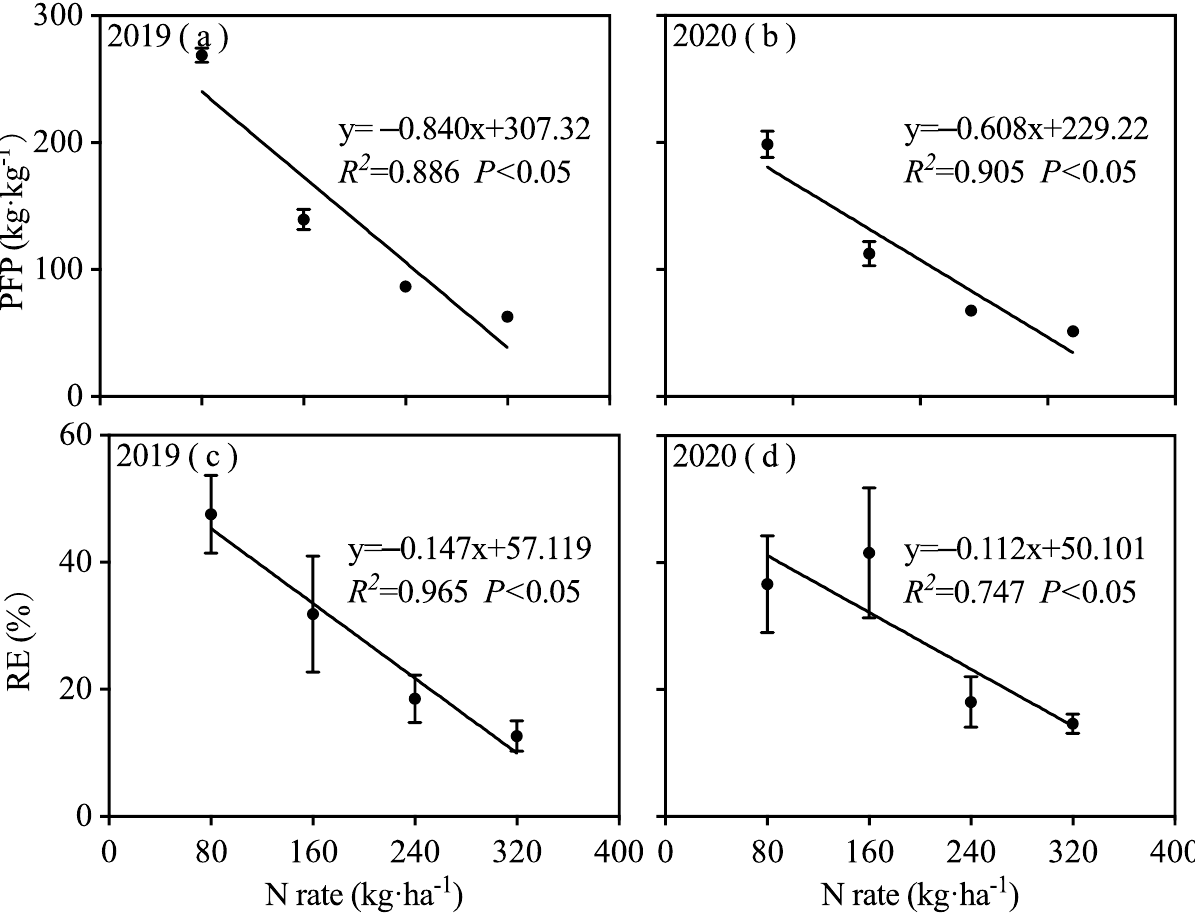
Figure 5. Relationships of PFP ( a , b ) and RE ( c , d ) of applied N for forage sorghum with different N application rates in 2019 and 2020.